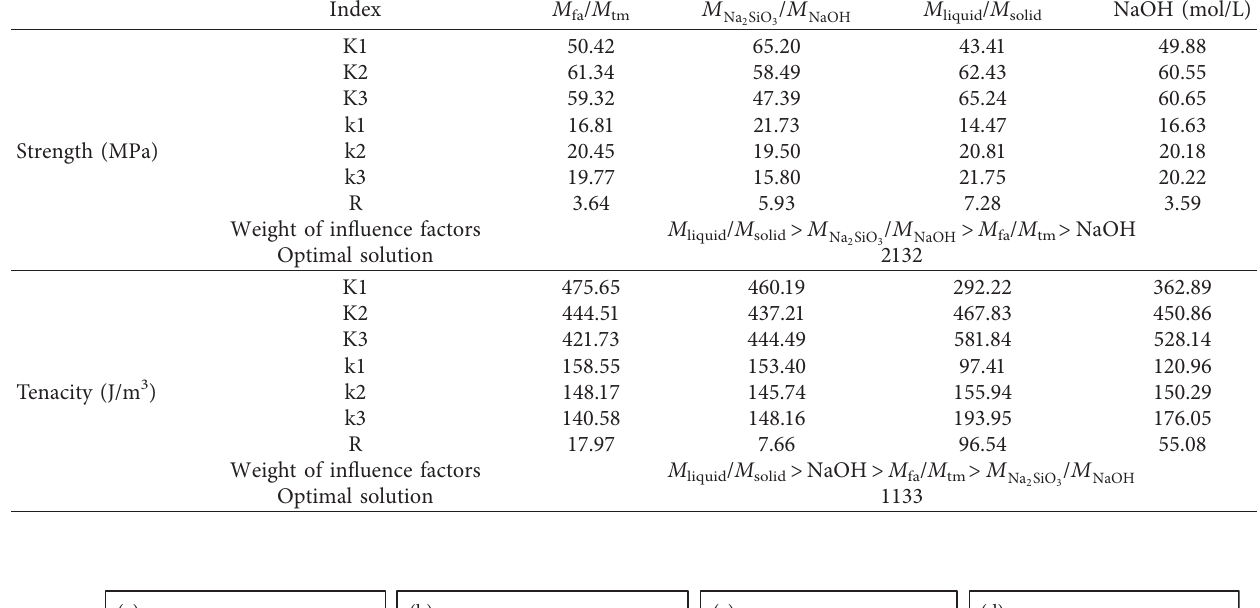
Table 4: Details of orthogonal analysis.